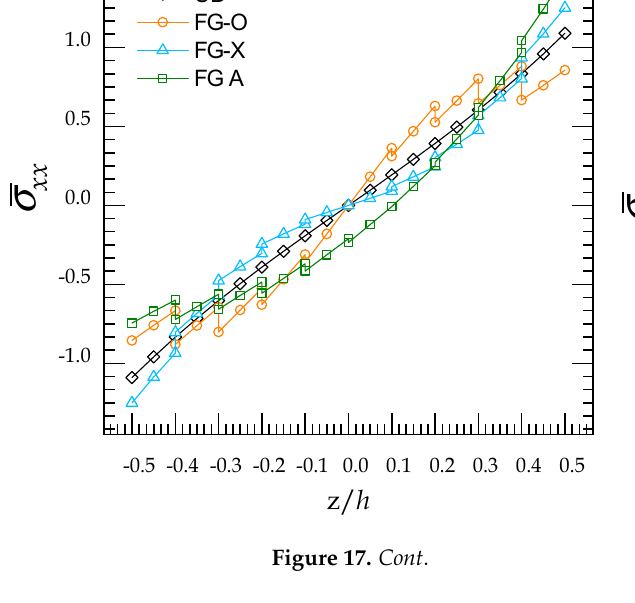
-0.5 -0.4 -0.3 -0.2 -0.1 0.0 0.1 0.2 0.3 0.4